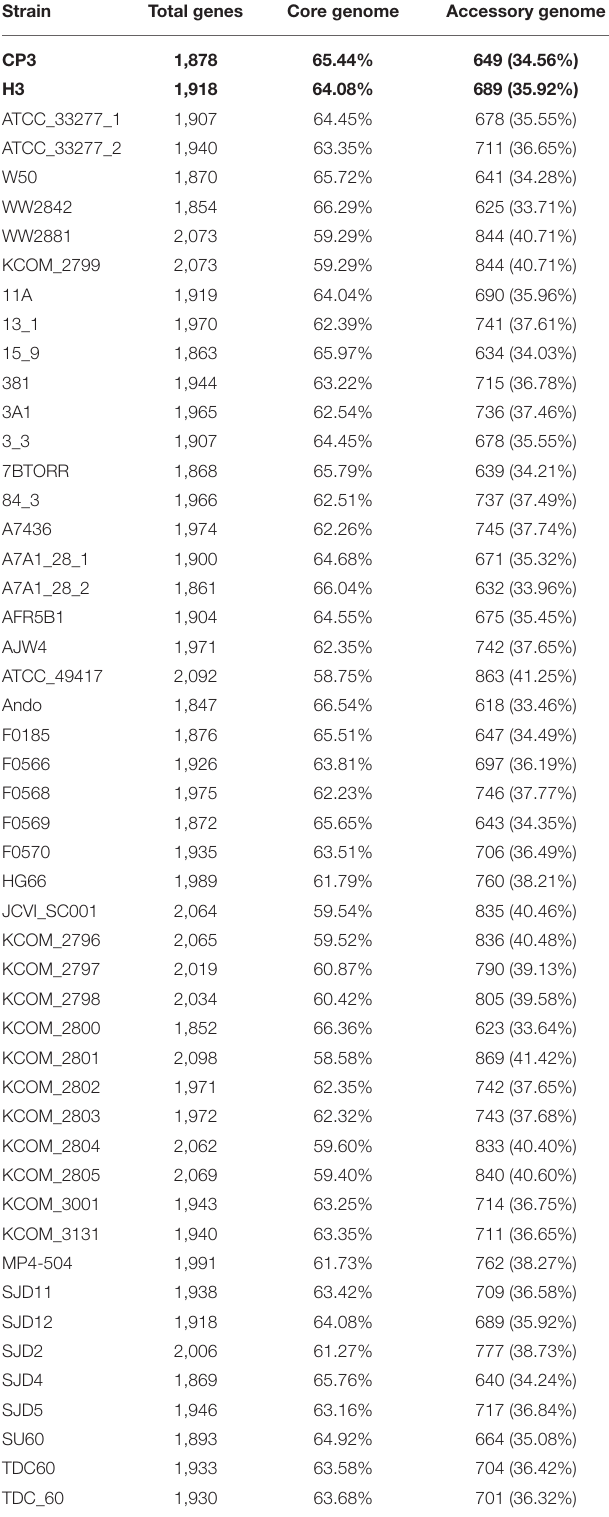
TABLE 1 | Pan-genome results of the 64-genome Porphyromonas gingivalis dataset. Strain Total genes Core genome Accessory